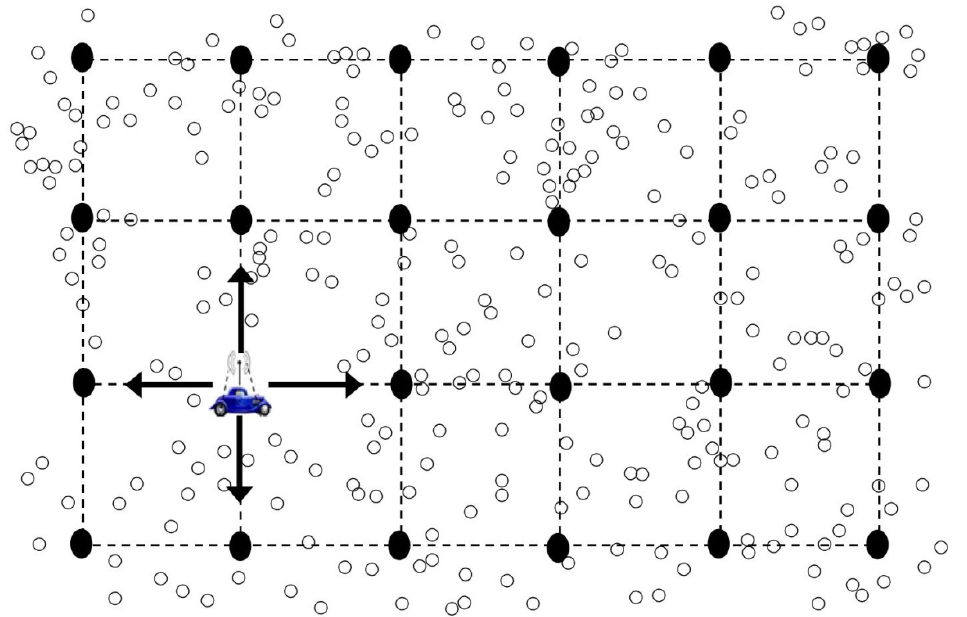
for network traversal 0